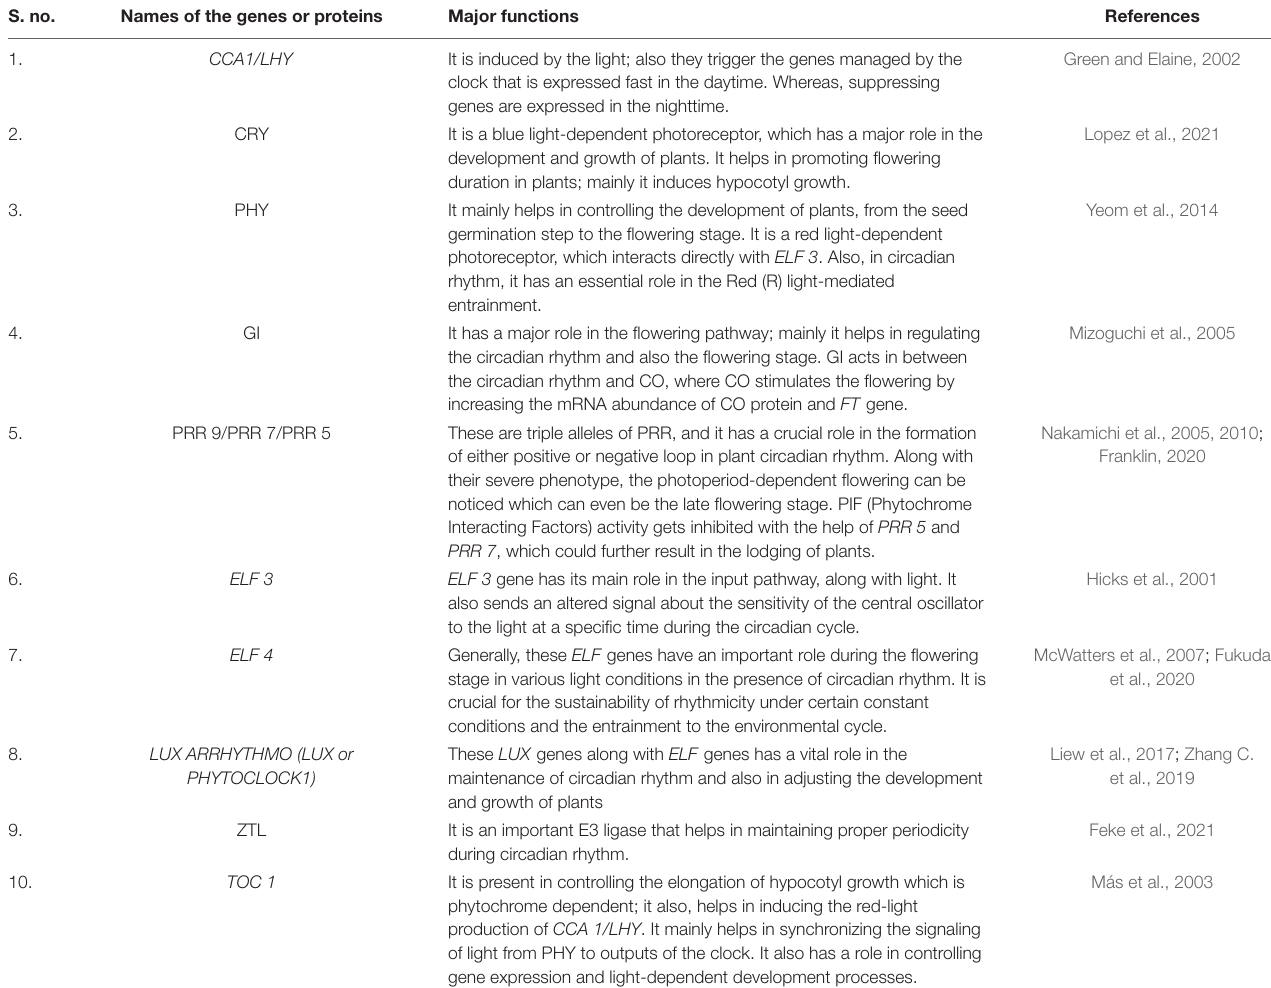
TABLE 1 | Specific genes and proteins present in plant circadian rhythm and its major functions. S. no. Names of the genes or